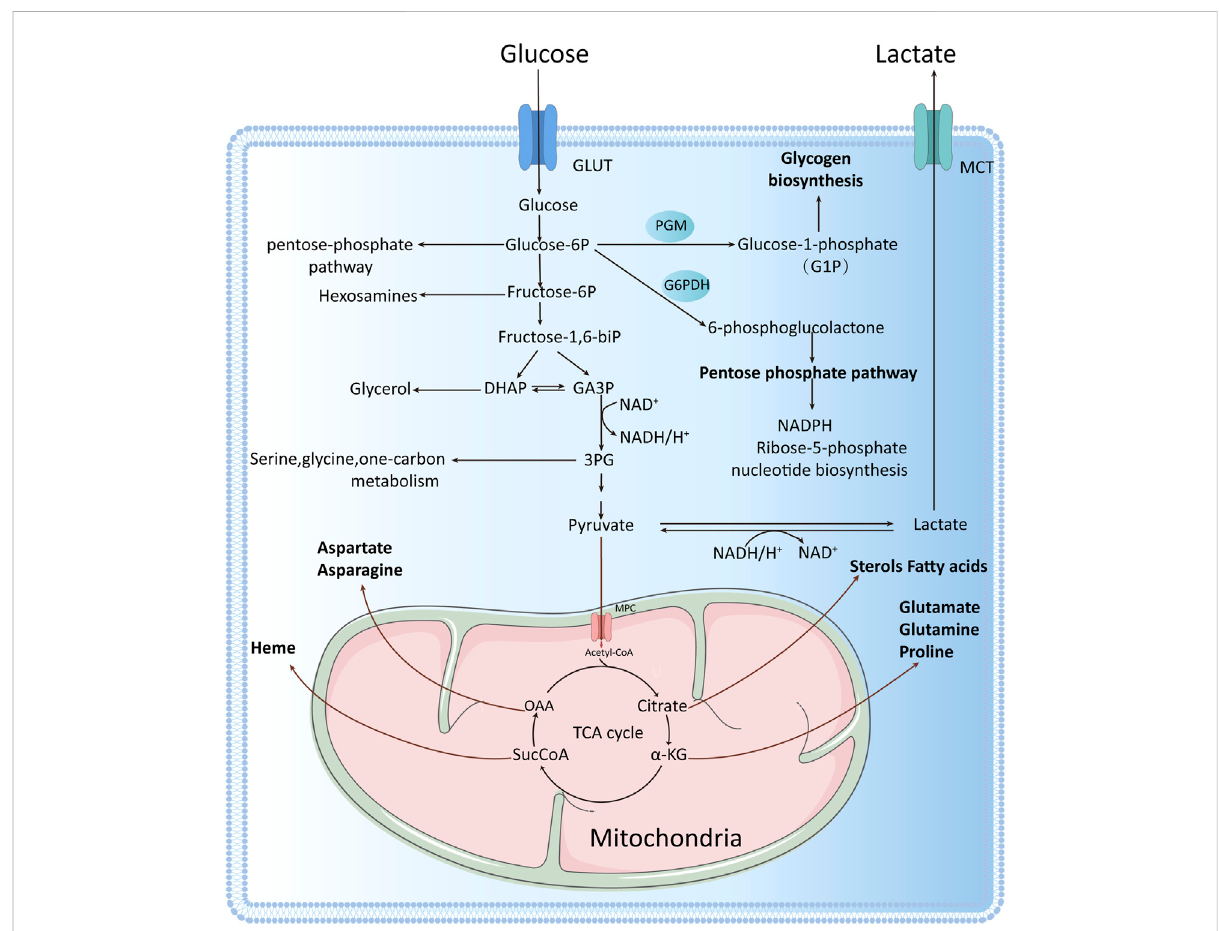
FIGURE 1 One glucose molecule is broken down intracellularly to two pyruvate molecules, which can enter the mitochondrion to participate in the tricarboxylic acid (TCA) cycle under aerobic conditions or to produce lactate under anaerobic conditions. Tumor cells rely mainly on aerobic glycolysis for energy production, even under oxygen-suf fi cient conditions, with one glucose molecule entering the glycolytic pathway to produce two net ATP molecules. Glycolysis involves the production of many intermediate metabolites apart from ATP. These intermediate metabolites canparticipateinotherbiosyntheticpathways,forexample,glucose-6-phosphatecanenterthepentosephosphatepathway,fructose6-phosphate canenterthehexosaminebiosynthesispathway,dihydroxyacetonephosphatecanbeconvertedtoglycerol3-phosphate,andglycerol3-phosphate can be converted to serine, cysteine, and glycine, among